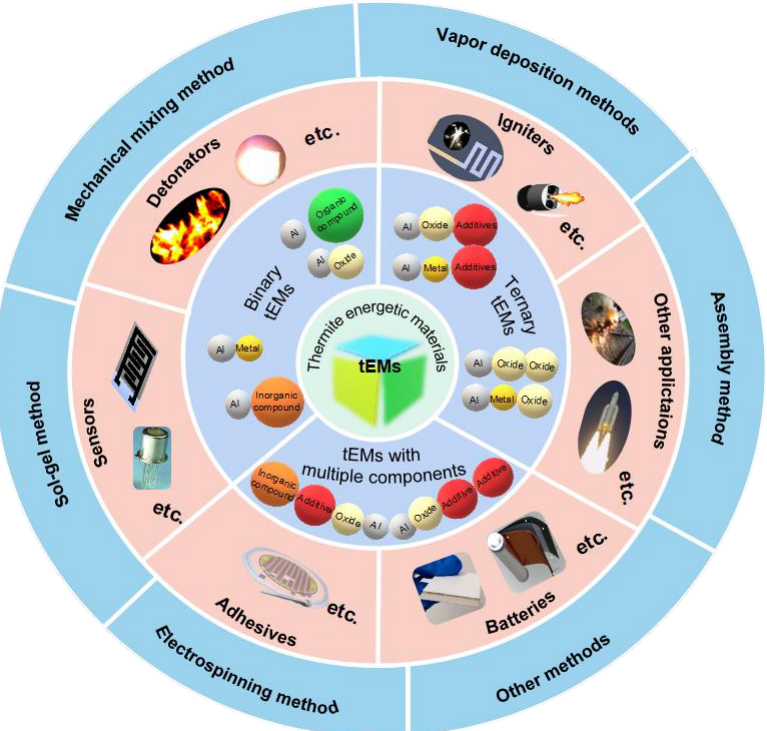
Figure 1. The classification, application and preparation process of highly reactive tEMs.